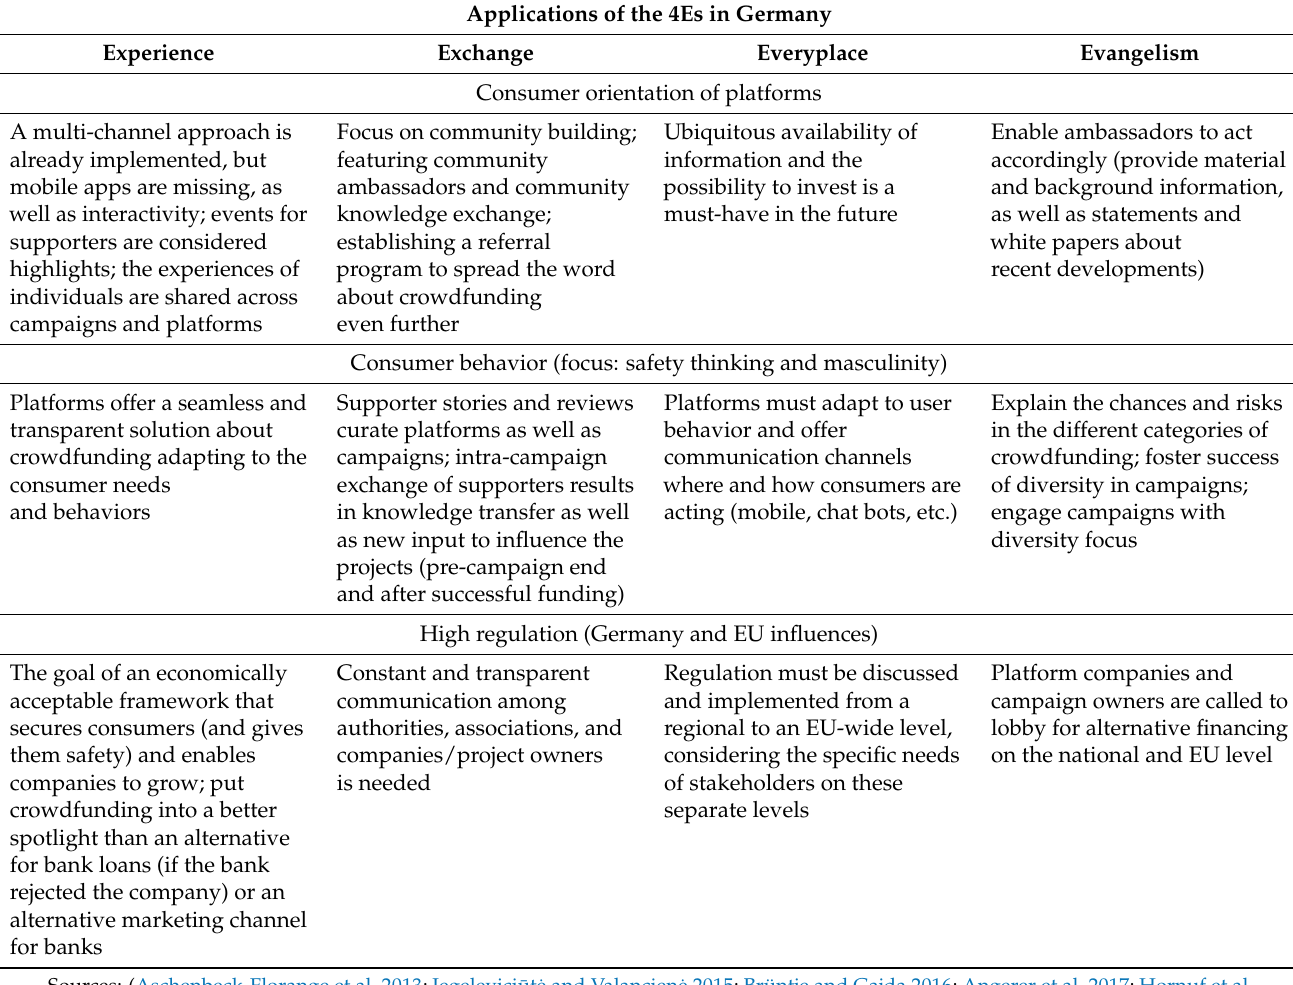
Table 2. Application of the 4Es marketing mix in the context of crowdfunding in